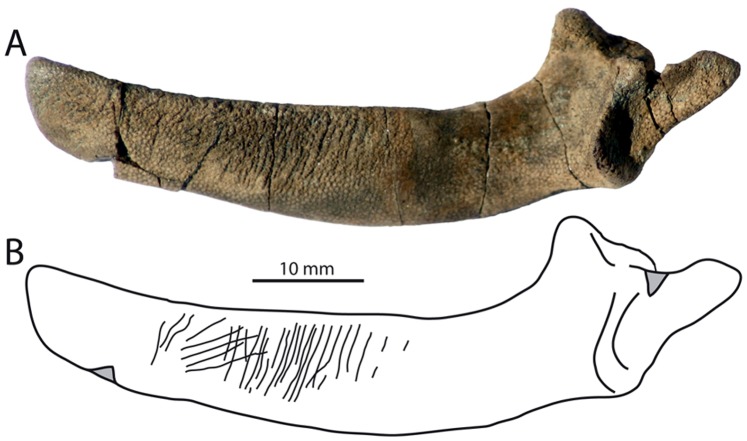
Calcified mandibular cartilage (A) of skate (Raja sp., cf. R. binoculata; UCMP 219035) with two sets of linear bite marks (B).